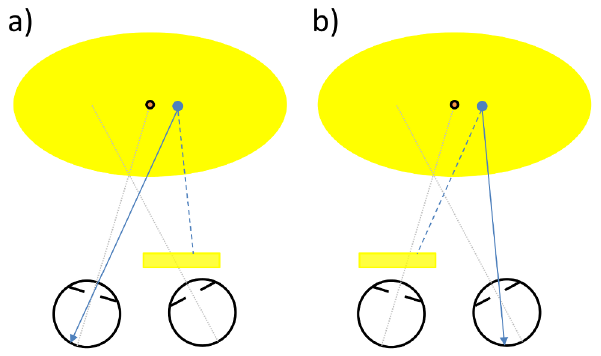
Figure 1. Schematic arrangment of viewing conditions for a hypothetical strabismic participant with a right eye (RE) esotropia. a) Yellow filter is placed in front of the strabismic RE. This makes the blue stimulus to be detected invisible to the RE. Hence sensitivity to the blue stimulus reflects LE (fixating eye) performance only. Dissociation between the eyes is minimal because the RE sees all except the blue stimulus. There is minimal dissociation because both eyes are presented with yellow background. b) Identical to a) except that yellow filter is in front of the non-strabismic LE. Sensitivity to the blue stimulus is now determined by the RE alone, albeit at a greater retinal eccentricity as the RE remains in its habitual motor position. When no yellow filter is used (not shown), the blue stimulus is potentially visible to both eyes and thus the detection threshold reflects sensitivity in habitual viewing (i.e. with both eyes open, blue stimulus available to both eyes and the deviating eye in its anomalous motor position). These three viewing conditions enable the monocular- and binocular-sensitivities to be determined and compared with the eyes in identical positions for the three conditions. Thus an examination of the extent, if any, to which the deviating eye contributes to sensitivity in habitual viewing is